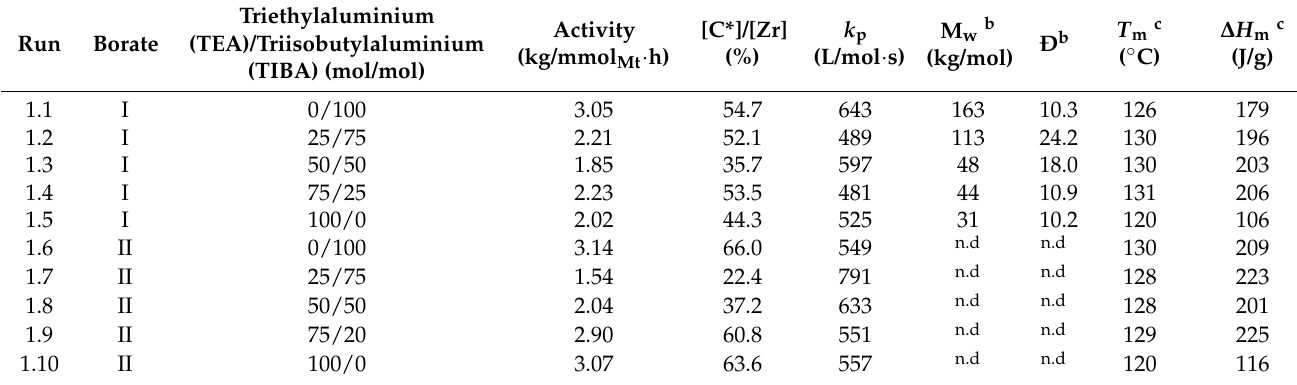
Table 1. Results of ethylene polymerization with Mt-I a .